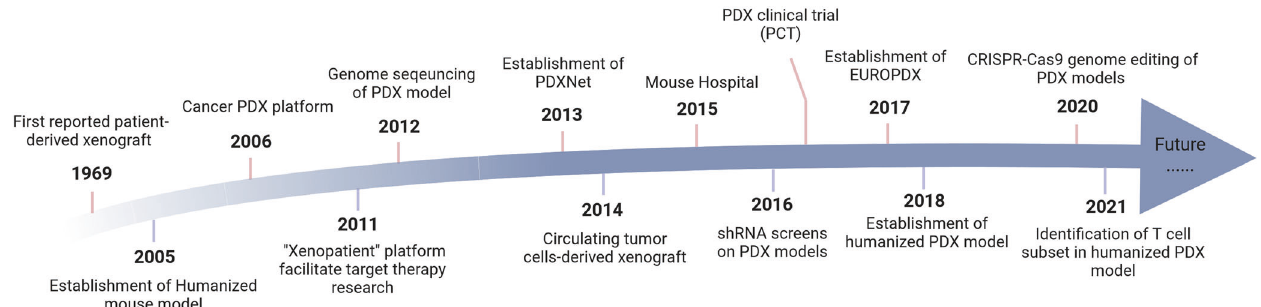
Fig. 2 The brief timeline of milestones in PDX